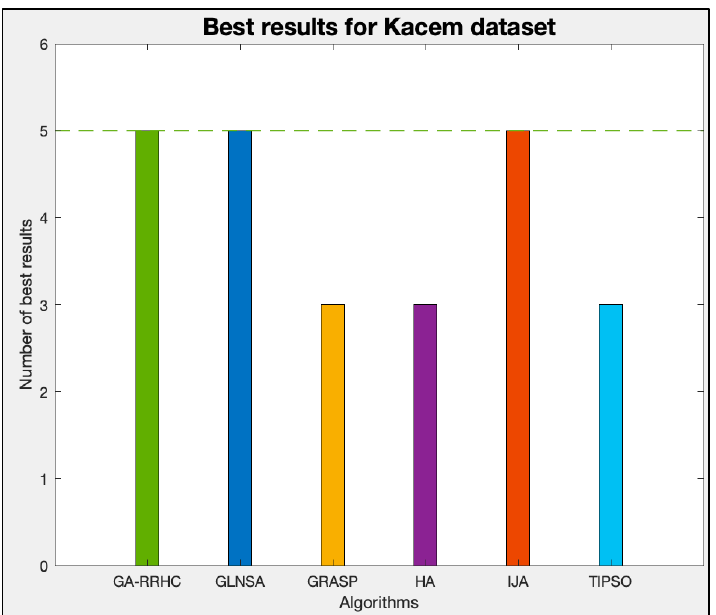
Figure 13. Number of best results per algorithm for the Kacem dataset.